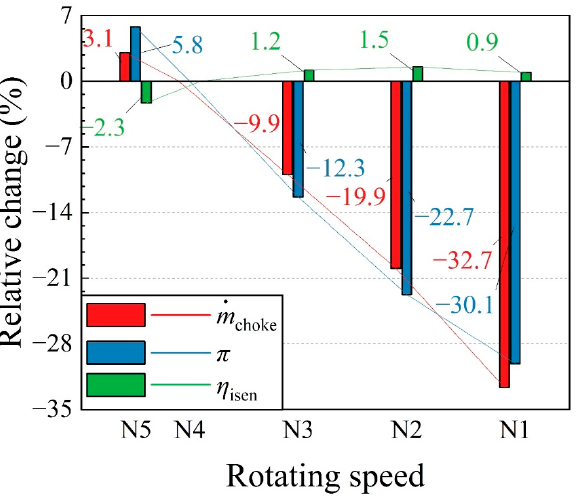
. m choke , π , and η isen for the high-throughflow fan stage under , π , and η isen for the high-throughflow fan stage under dif- choke